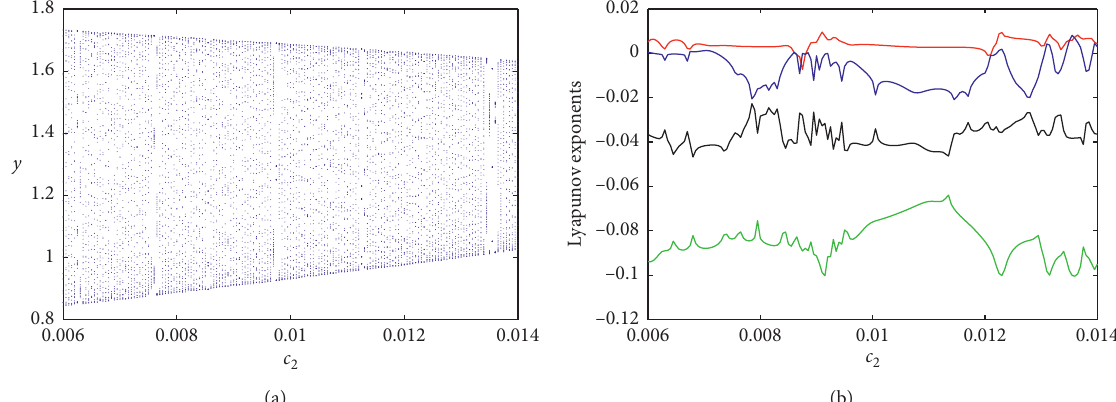
Figure 3: System (1) time sequences diagram.